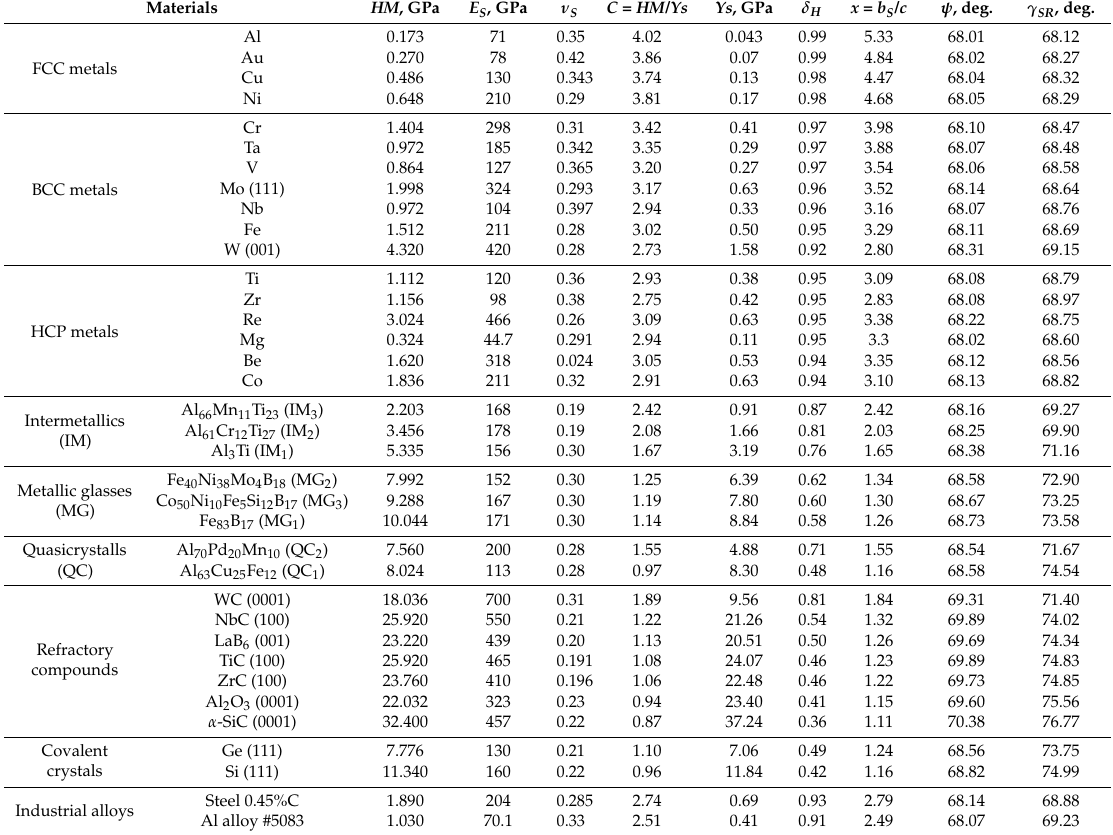
Table 1. Mechanical characteristics of materials (Meyer hardness HM , Young modulus E S , and Poisson’s ratio ν S ) and characteristics calculated according to the core indentation model (Tabor parameter C , yield stress Y S , plasticity characteristic δ H , relative size of elastoplastic zone x, apex angle of indenter under load ψ , and relaxed effective apex angle of a hardness indent γ SR